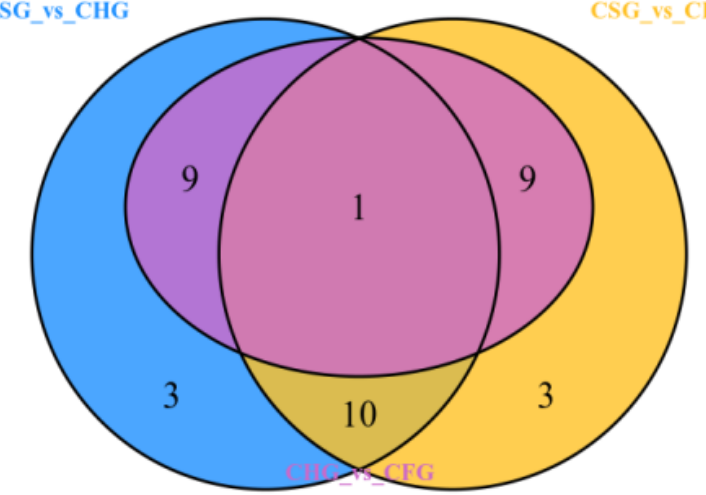
Figure 6. Venn diagram showing numbers of metabolites at intersections. Table 1. List of biologically active, upregulated flavonoid metabolites detected in